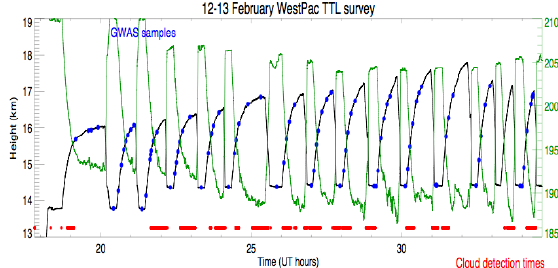
Figure 13. Repeated profiles through the TTL during